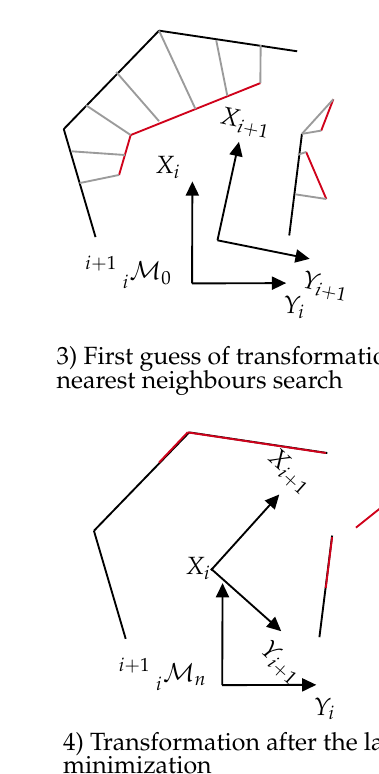
Figure 4. Principle of the ICP algorithm. At each iteration, the closest points are extracted between the two scans. From these matches, a transformation is processed and applied on the second scan. Then, the process iterates until a given cost criterion is